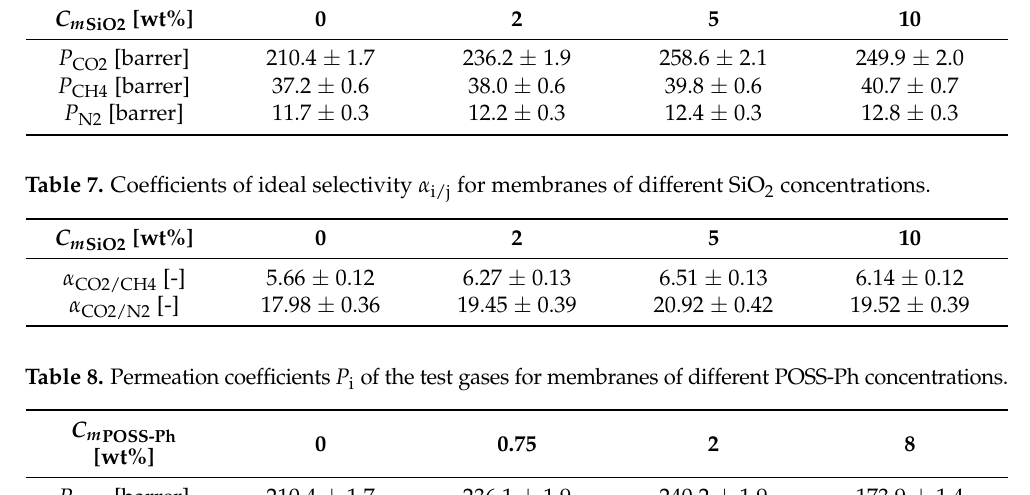
Table 6. Permeation coefficients P i of the test gases for membranes of different SiO 2 concentrations.